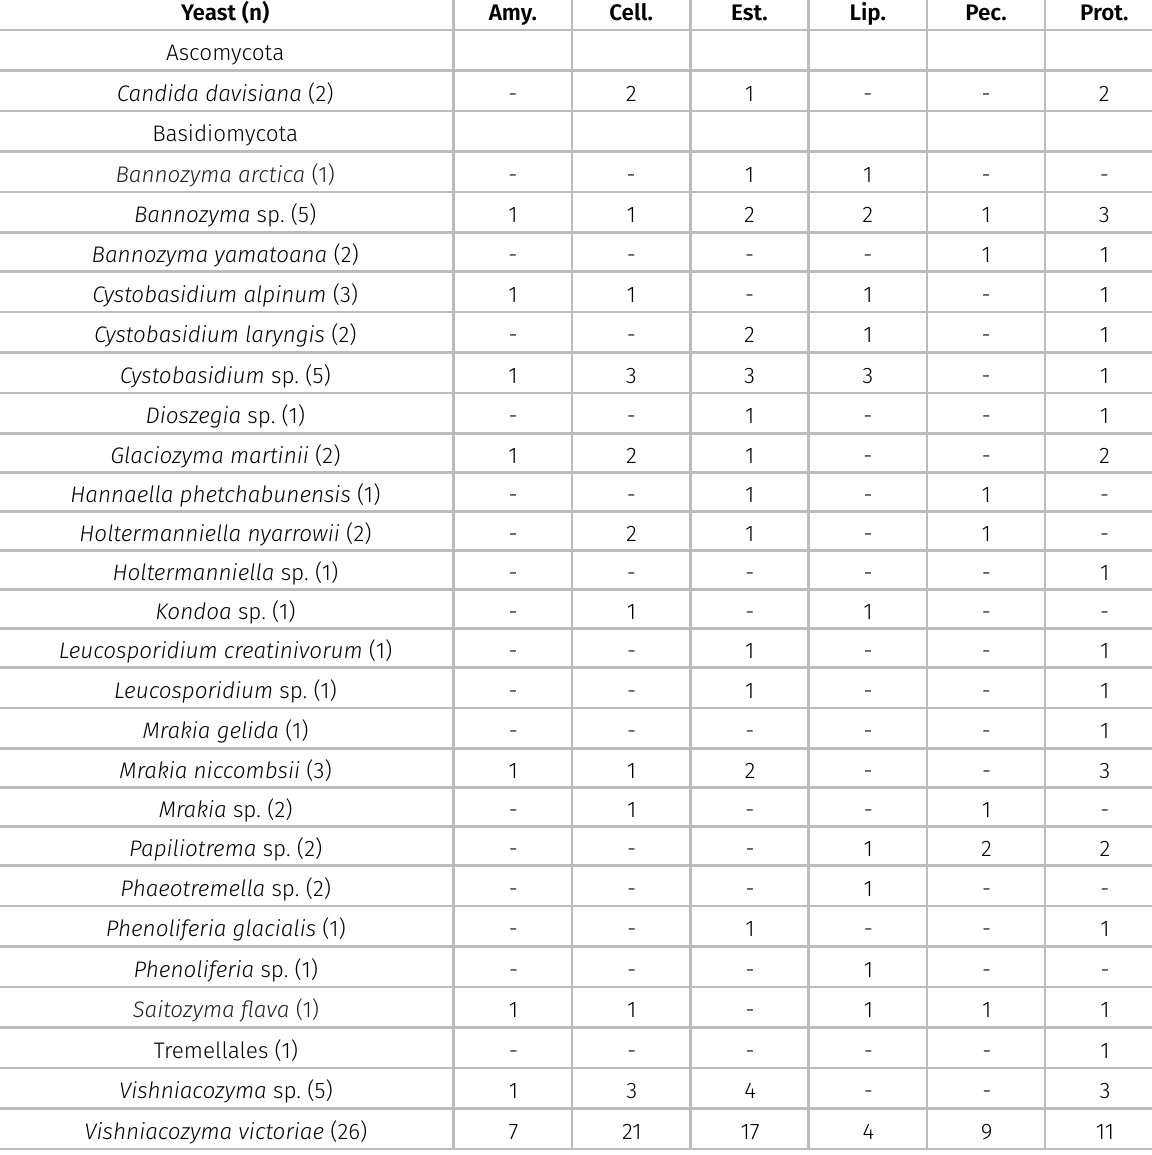
Table II. Number of species of yeast isolated from Antarctic lichens with positive enzymatic activity (n): amylase (Amy), cellulase (Cell), esterase (Est), lipase (Lip), pectinase (Pec), and protease (Prot). Yeast (n)